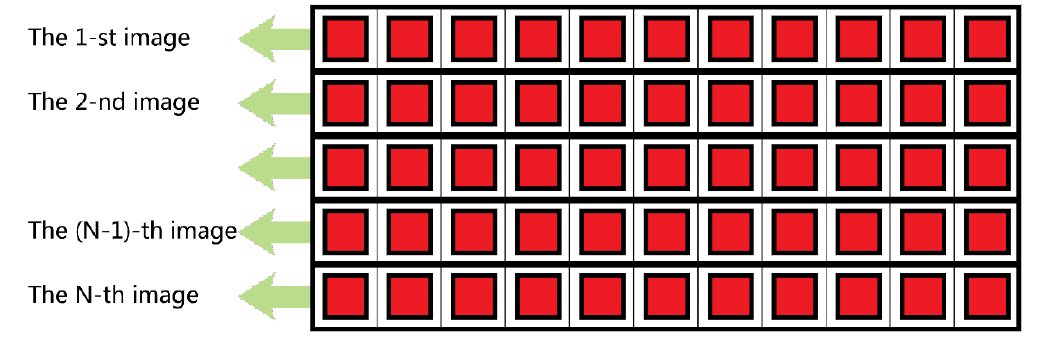
Figure 1. The diagram of MS-CMOS structure.